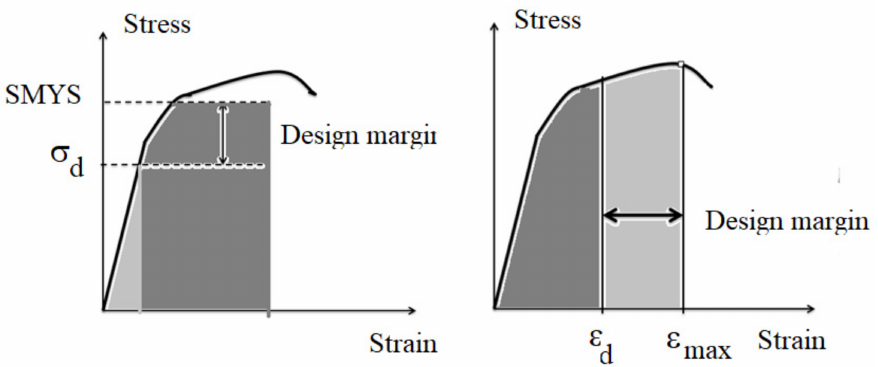
Figure 18. Principle of stress- and strain-based designs (SDB). (SMYS, standard minimum yield strength; σ d , stress demand; ε d , strain demand; and ε max , strain